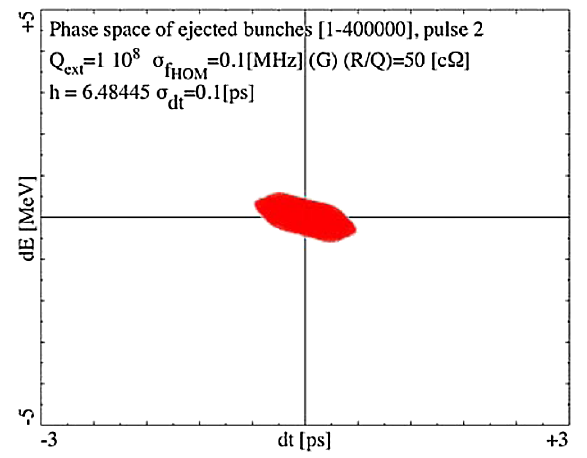
FIG. 7. (Color) Phase space as in Fig. 6 (identical linac) but considering phase noise from bunch position jitter at injection with (cid:1) dt ¼ 0 : 1 ps